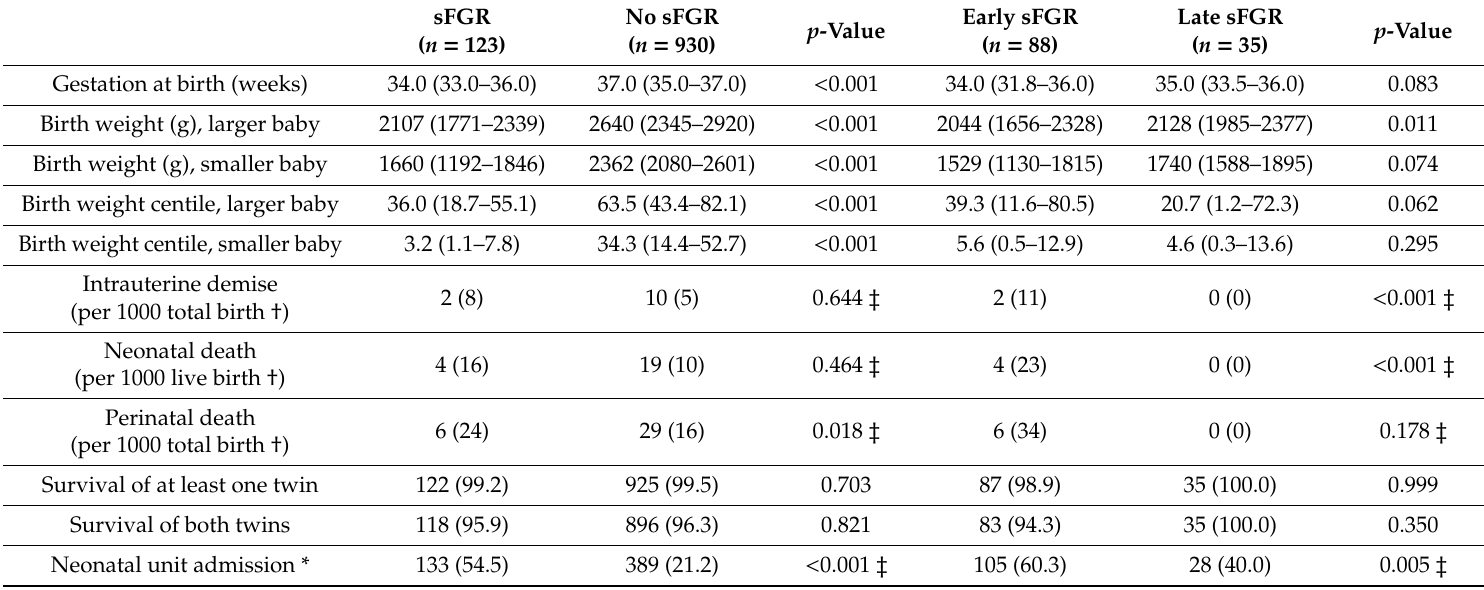
Table 4. Perinatal outcomes in dichorionic twin pregnancies according to whether they were complicated by sFGR or not according to the Delphi diagnostic criteria and stratified according to the gestational age at diagnosis. Data are shown as number (%) or median